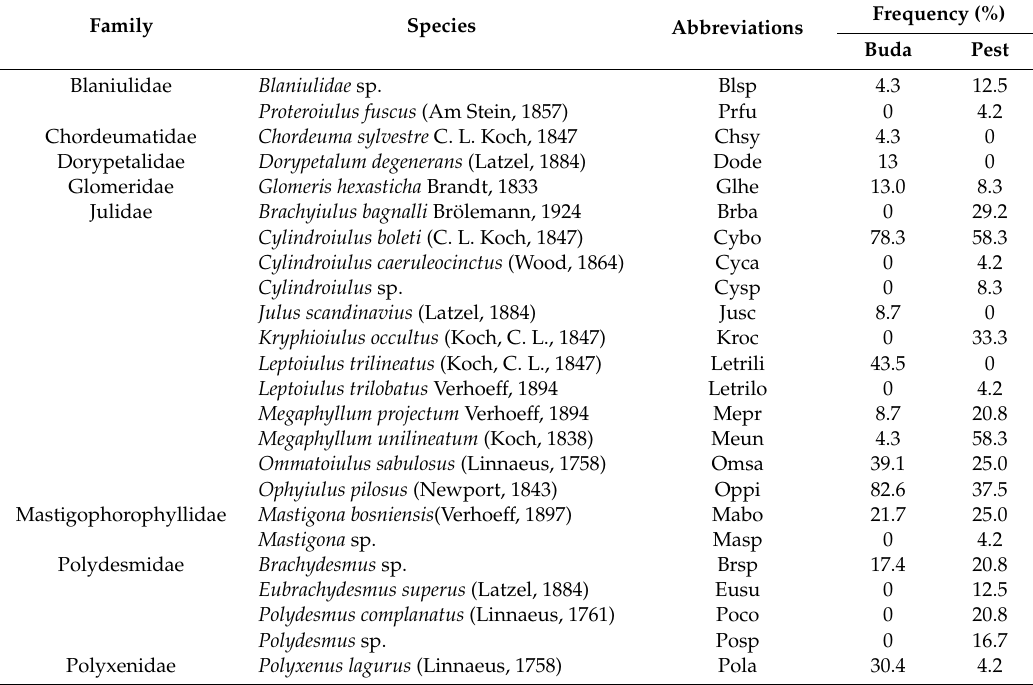
Table 2. Species list of millipedes with their frequency of occurrence in Buda and Pest. Abbreviations of species names used in Figure